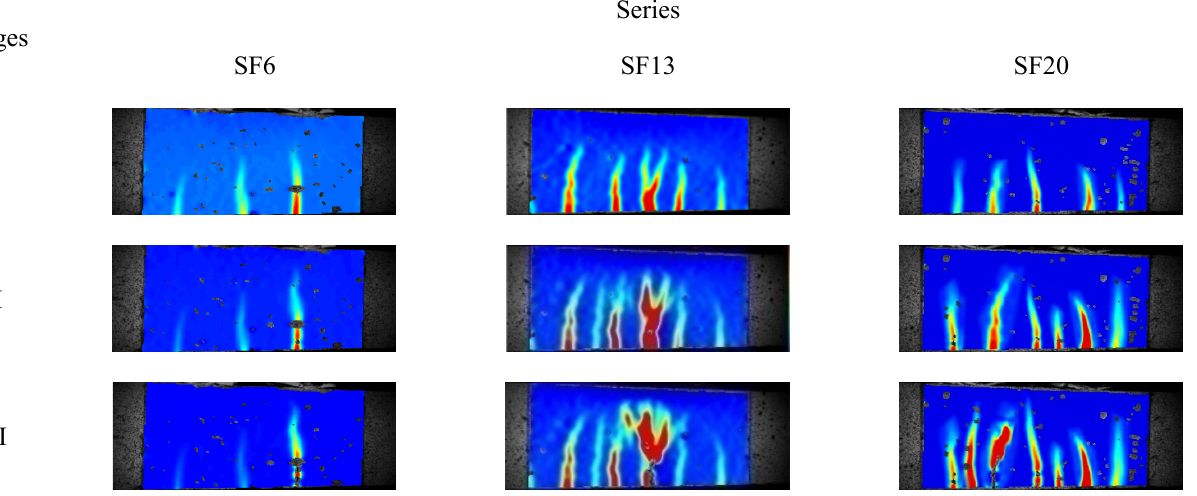
Figure 5. Characterization of strain fields of the region of interest by using DIC technique.